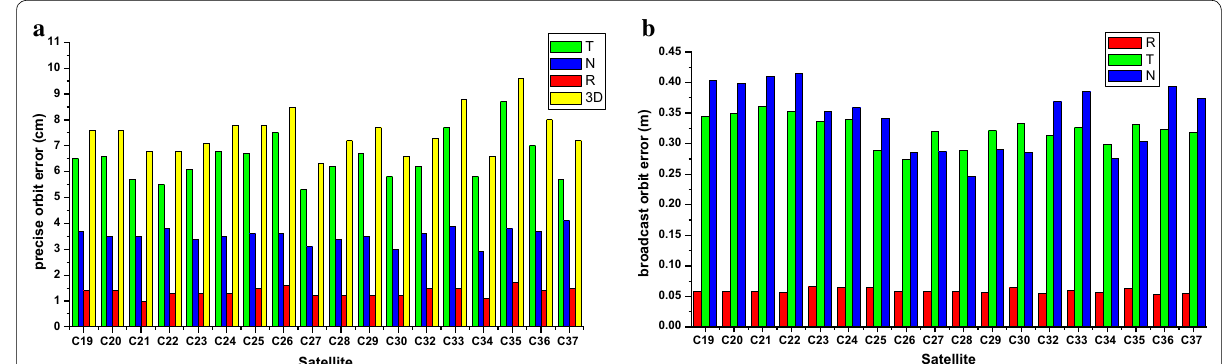
Fig. 1 a Precise orbit accuracy of the BDS-3 basic constellation. b Broadcast orbit accuracy of the BDS-3 basic constellation